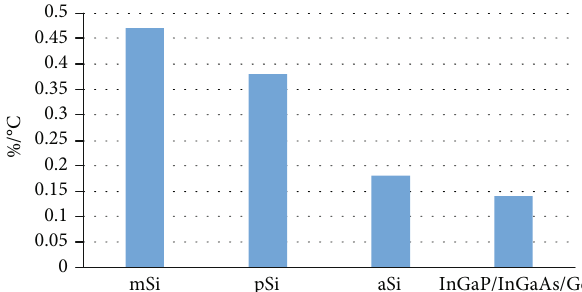
Figure 7: The decrease percentage in maximum power for di ff erent types of photovoltaic